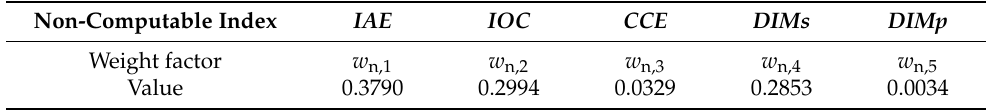
Table 8. Weight factors of 5 non-computable indices.